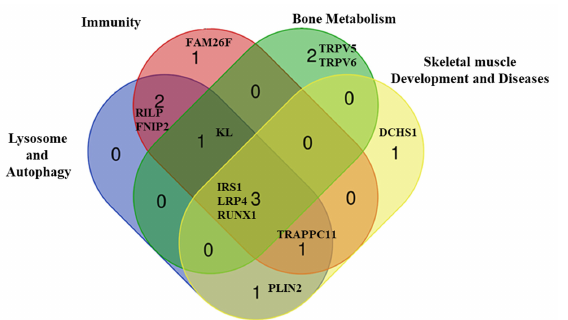
Figure 3. Venn diagram. Venn diagram showing the 12 modifiers genes involved across different interconnected pathways: lysosome–autophagy-related genes, genes involved in immunity, in bone metabolism and those related to the development of skeletal muscle and/or skeletal muscle diseases.